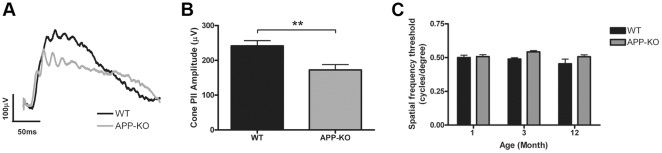
The function of the cone pathway is altered in the APP-KO mouse.(A) Representative waveforms of the cone ERG recorded from 3 month old WT (black) and APP-KO (grey) mice in response to the second flash of a twin flash paradigm ERG (2.1 log cd.s/m2 flash intensity). (B) The cone pathway post-photoreceptor response, the cone PII was found to be smaller in amplitude in APP-KO mice when compared with the WT response. (C) The photopic visual acuity, assessed using the optokinetic reflex to determine the spatial frequency threshold, was physiologically similar between APP-KO and WT mice with age. Results expressed as mean +/− SEM. **, p<0.01.